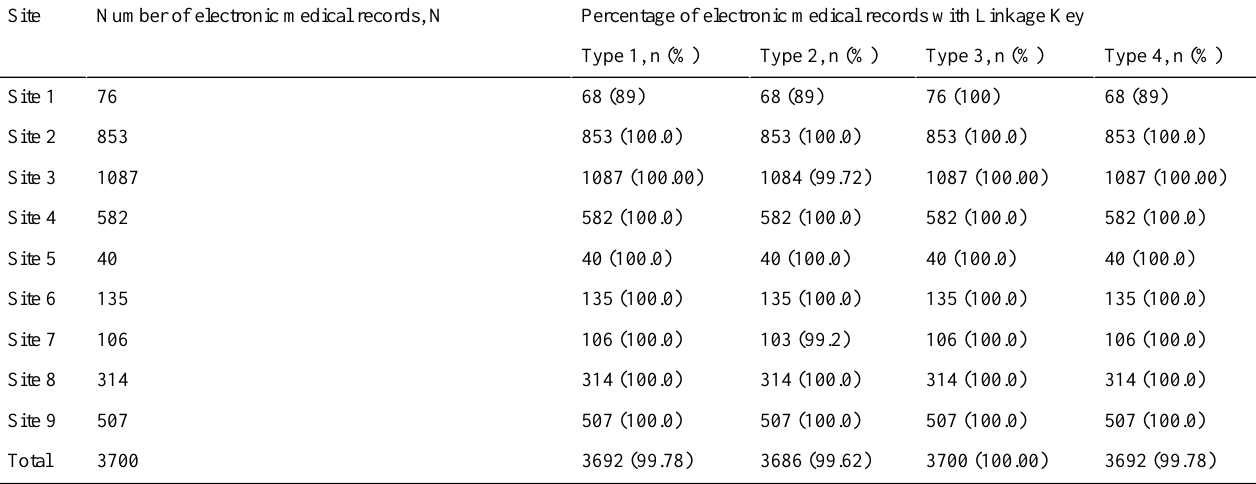
Table 2. Percentage of electronic medical records in the PrEPX gold-standard dataset by linkage key type and site.